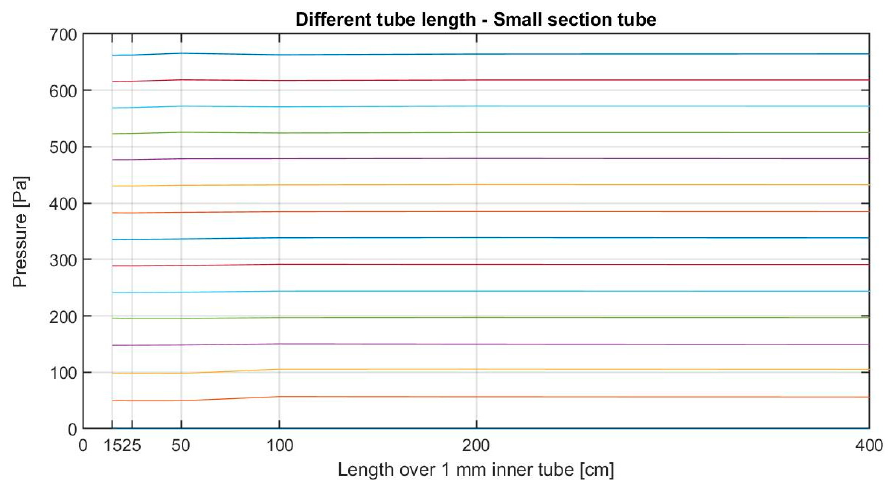
Figure 10. Static pressure measurement using a 1 mm inner tube of different lengths.